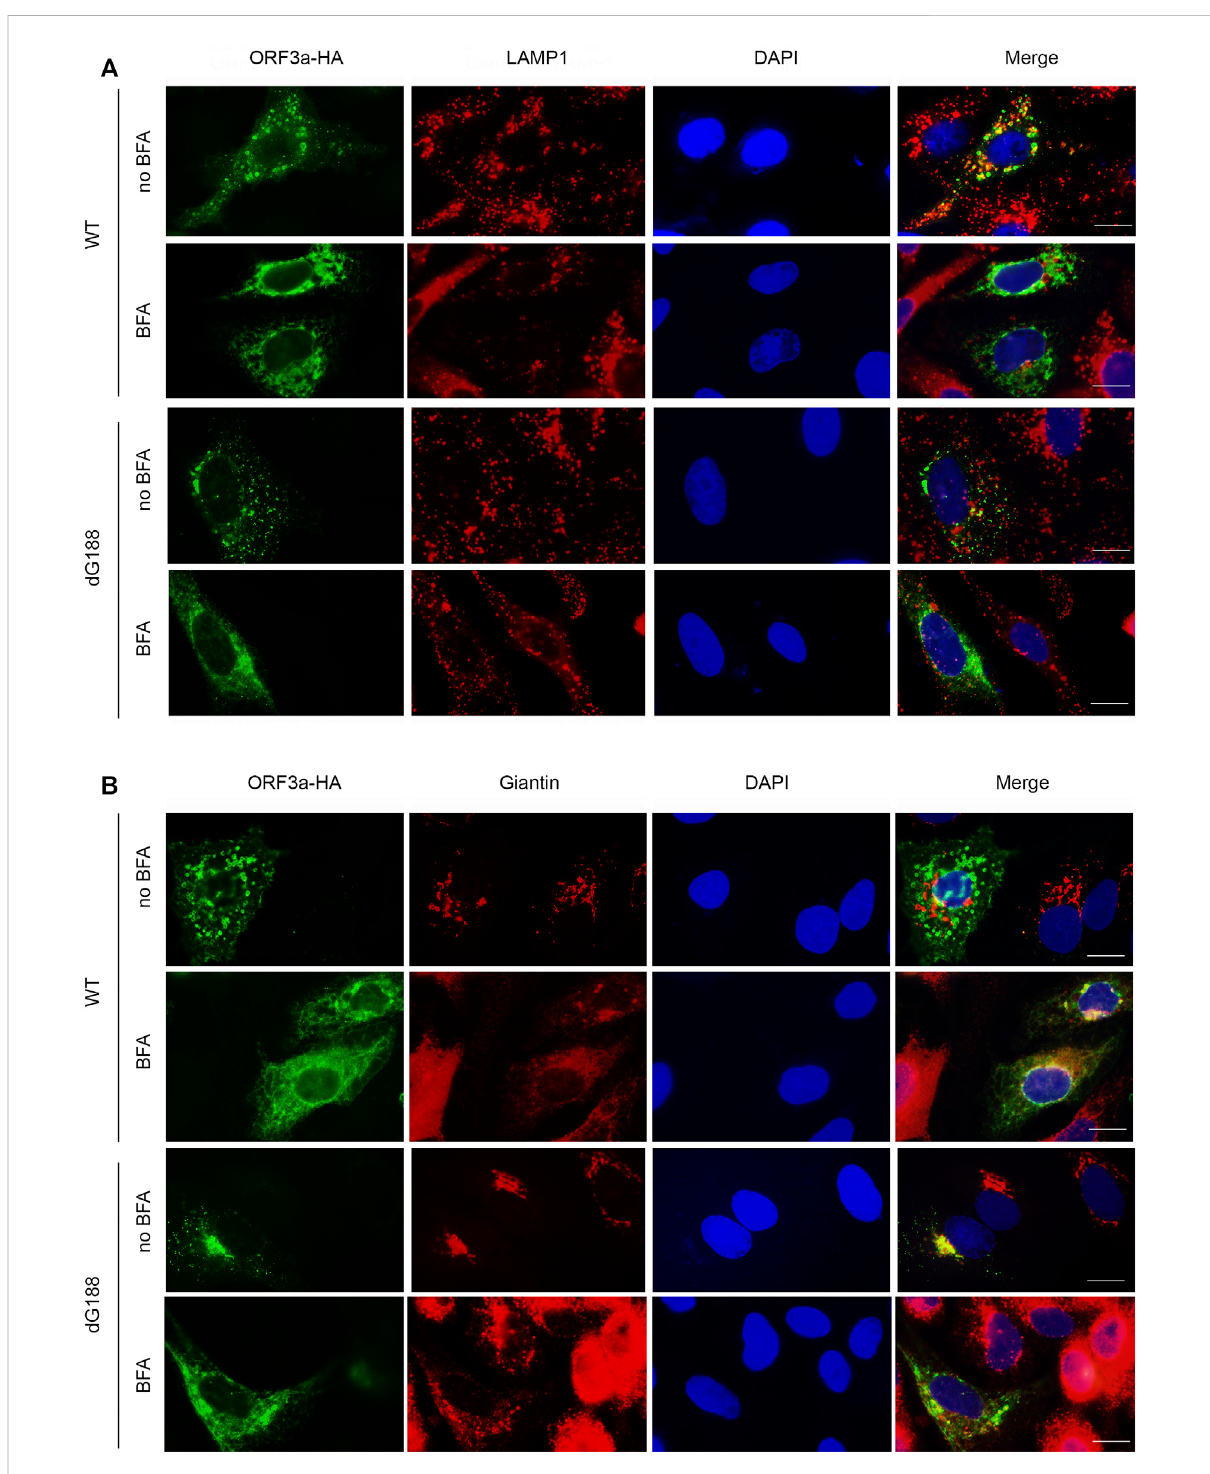
FIGURE 4 The dG188 mutant loses its ability to move out of the Golgi apparatus. The WT ORF3a or the dG188 mutant-carrying plasmid was transfected into A549 cells for 5 h. The cell cultures transfected with either plasmid was then treated with or without 1 µM Brefeldin A (BFA). Twenty hours after BFAtreatment,thecellswere fi xedfortheIFAusinganti-HAantibodytostainORF3a(green).TheLAMP-1antibody(red)wasusedtoshowlysosomes (A) , and the Giantin antibody (red) was used to show the Golgi apparatus (B) . Scale bar: 10 µm.